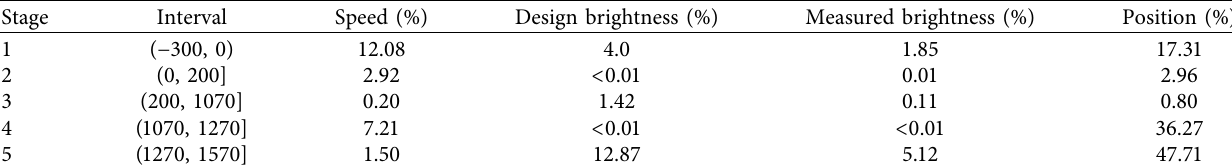
Table 1: The sensitivity analysis of